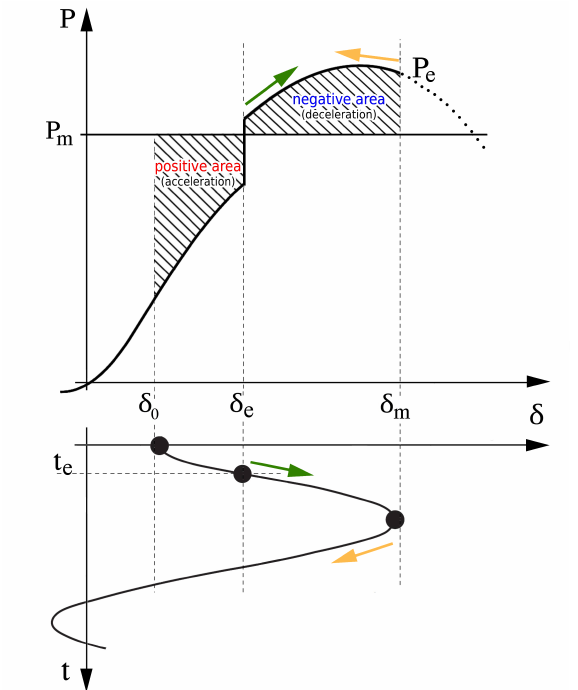
Figure 1. Equal area criterion for a synchronous generator connected to an infinite bus. There is a δ m after which the area becomes negative and δ starts to decrease, i.e., stable